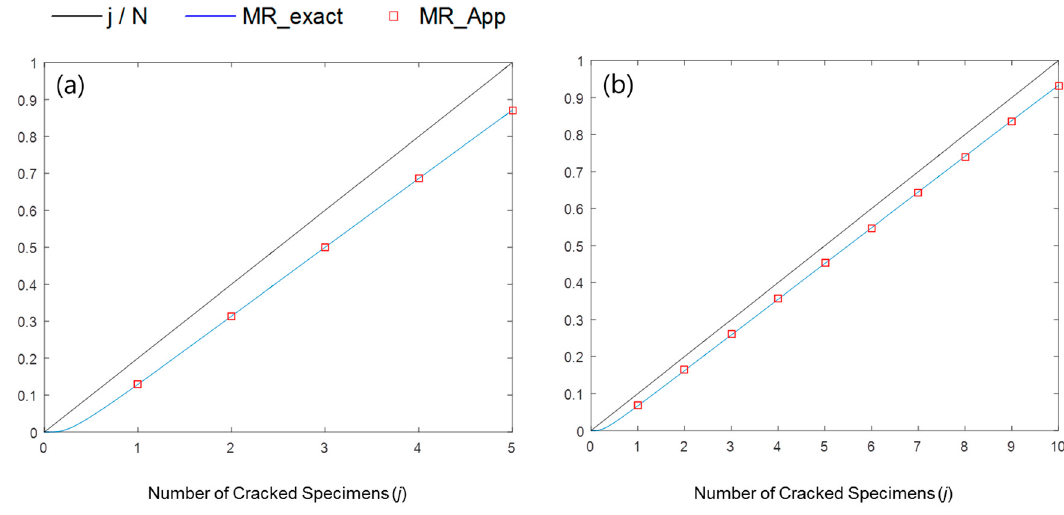
Figure 1. Comparison of exact median rank values (blue line) and their approximations (red squares) when: ( a ) N = 5; and ( b ) N = 10.